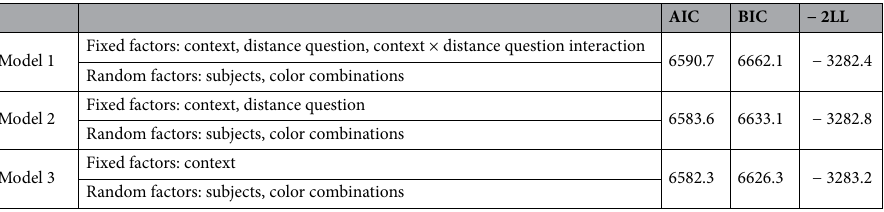
Table 3. (AIC) Akaike’s information criteria, (BIC) Schwarz’s Bayesian criterion, (− 2LL) − 2 LL-Likelihood. Information criteria on the linear mixed models performed on the entire